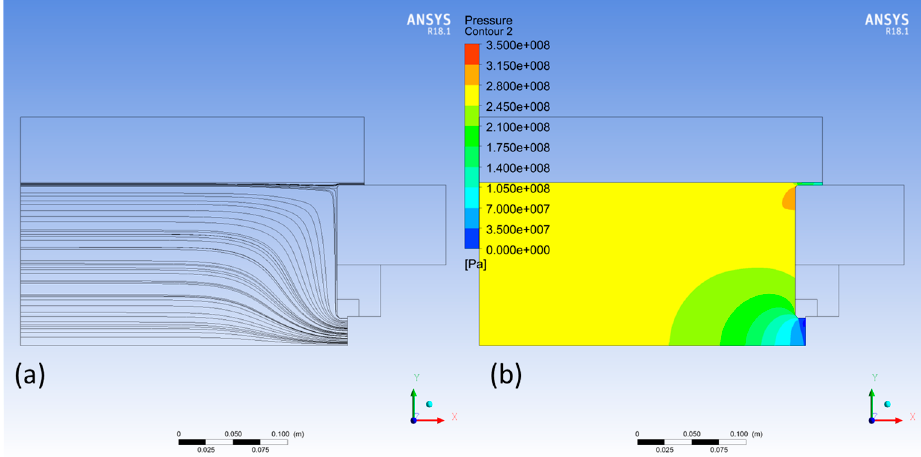
Figure 6. ( a ) Streamlines. ( b ) Pressure contours. Parameter values: f = 5 × 10 8 Ns/m 3 , S = 1.5 cm/s, f β = 0.5, T in = 715 °C, h = 1.7 W/(m 2 K).